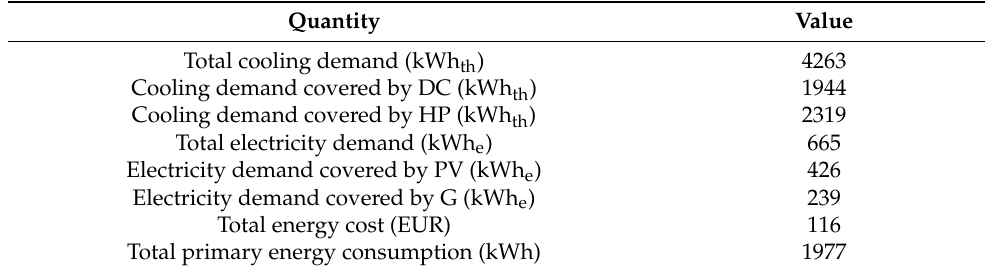
Table 4. Energy and cost performance with the RBC for the whole cooling